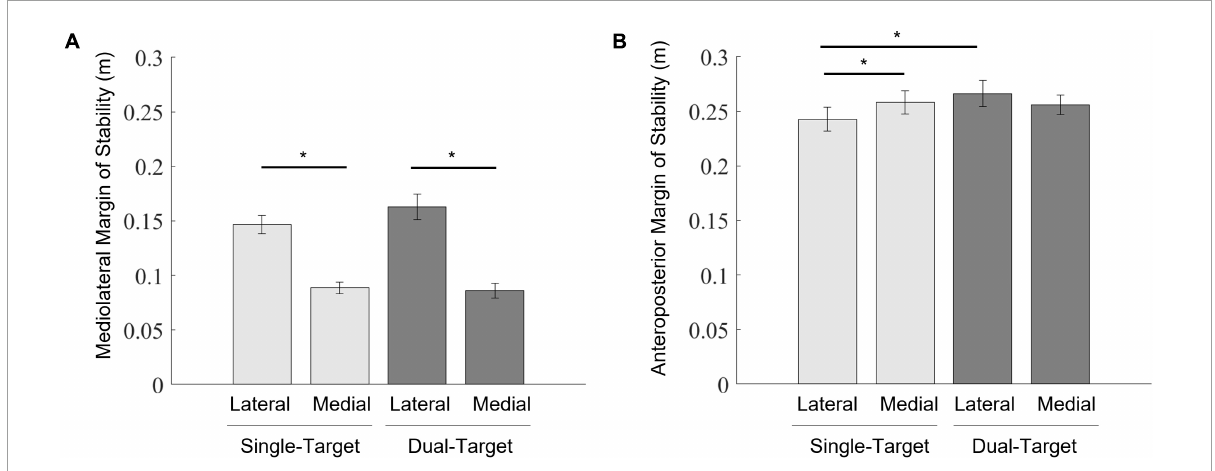
FIGURE7 Mean values of the mediolateral MOS (A) and the anteroposterior MOS (B) at foot contact. Light gray bars represent average values in the single-target condition, and dark gray bars represent average values in the dual-target condition. Error bars represent standard errors of the mean. An asterisk (*) indicates a significant difference in group means based on a post hoc analysis ( p <